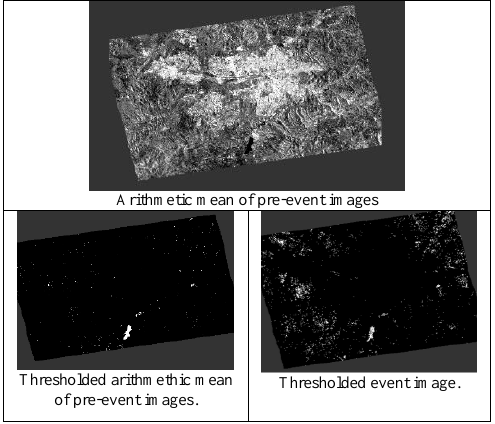
Figure 6. Mogan Lake (ROI-1) surroundings and histograms.